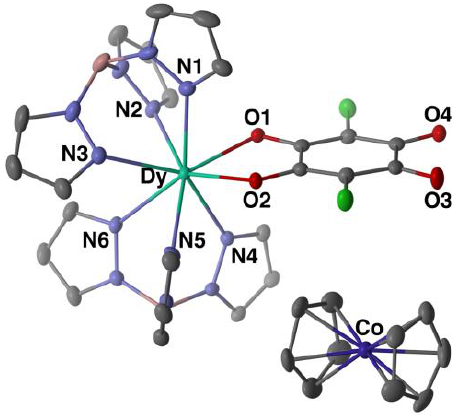
Figure 3. Molecular structure of 3 . H atoms are omitted for clarity.